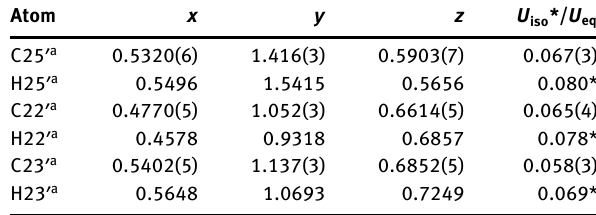
Table 2: Fractional atomic coordinates and isotropic or equivalent isotropic displacement parameters (Å 2